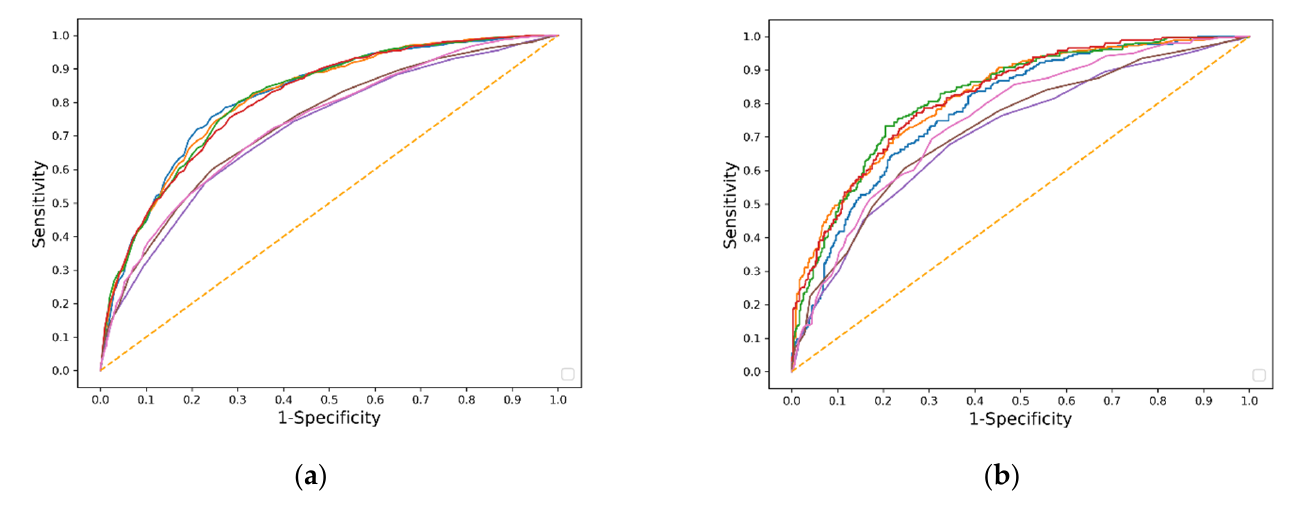
Figure 4. Area under operating characteristic (ROC) curves for prediction models trained in 80% pooled data ( a ) and tested in 20% pooled data ( b ). Red, RF (0.809, 0.821); Green, XGBoost (0.814, 0.823); Blue, MLP (0.818, 0.784); Orange, LR (0.814, 0.819); Brown, nonrenal SOFA score (0.735, 0.726); Purple, SOFA score (0.718, 0.710); Pink, HELENICC score (0.735, 0.752).